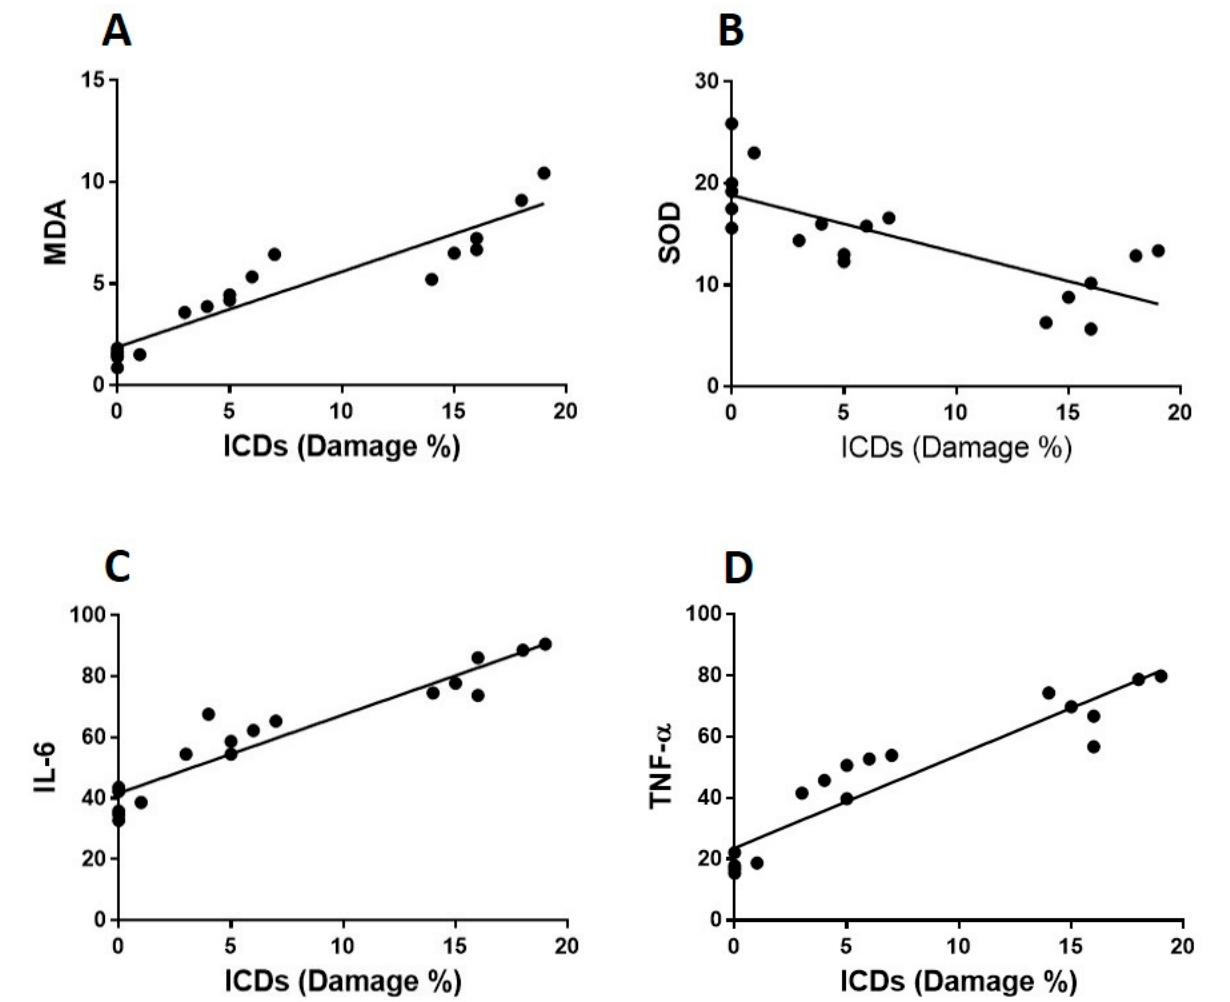
Figure 8. Correlation between cardiomyocyte intercalated discs (ICDs) and biomarkers of oxida- tive stress and inflammation. MDA, SOD, IL-6 and TNF- α heart homogenate levels were calculated in all rat groups. The correlation between the percentage damage of ICDs and oxidative stress biomarkers (MDA and SOD) are shown in ( A , B ), respectively. The correlation between the percentage damage of ICDs and proinflammatory cytokines (TNF- α and IL-6) has been demonstrated in ( C , D ), respectively.